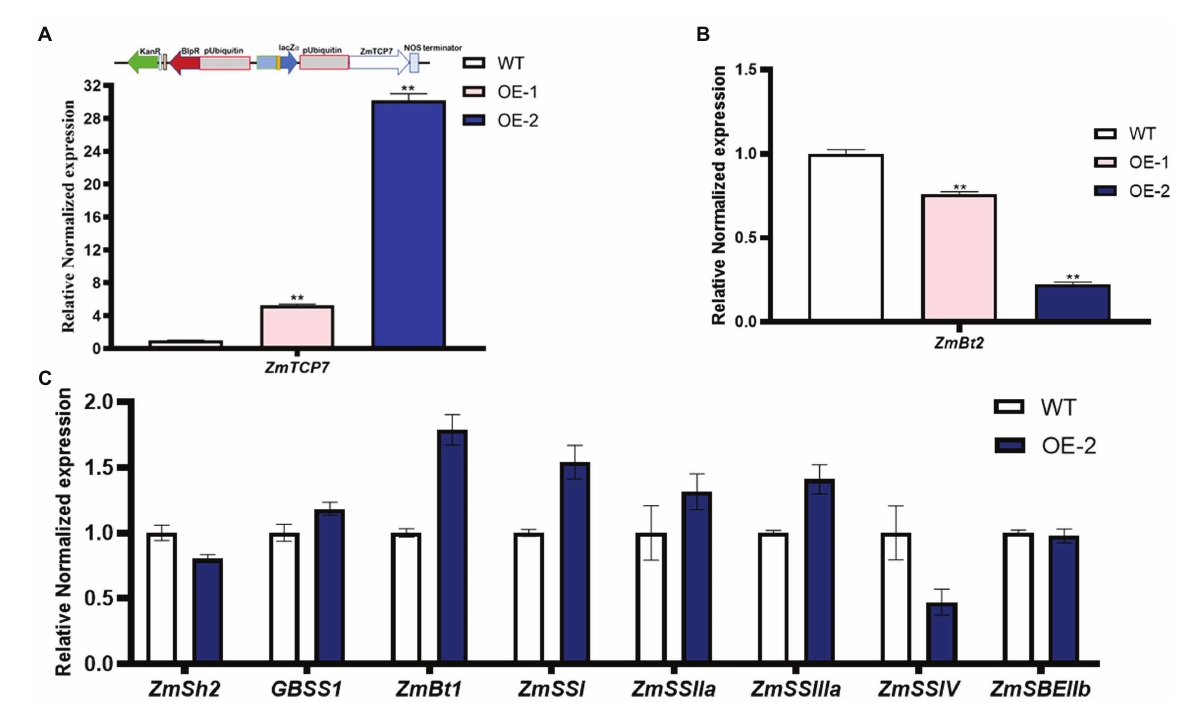
FIGURE 5 Transgenic overexpression analysis of ZmTCP7. (A) Schematic representation of the overexpression construct (upper panel) and the transcript levels of ZmTCP7 (lower panel) in the endosperms from kernels of the transgenic overexpression (OE) lines and non-transformed (WT) kernels from the same ear by RT-qPCR. (B) The ZmBt2 expression levels in the endosperm from kernels of the transgenic OE lines and WT by RT-qPCR assay. The significance of the difference between each transgenic OE line and WT was analyzed using a two-sided t-test (** p < 0.001); (C) Analysis of the expression of genes related to starch biosynthesis in endosperms from kernels of transgenic OE and WT by RT-qPCR analysis. The bars indicate the mean ± SD of three replicates. At least three independent experiments were performed and results were found to be consistent in all